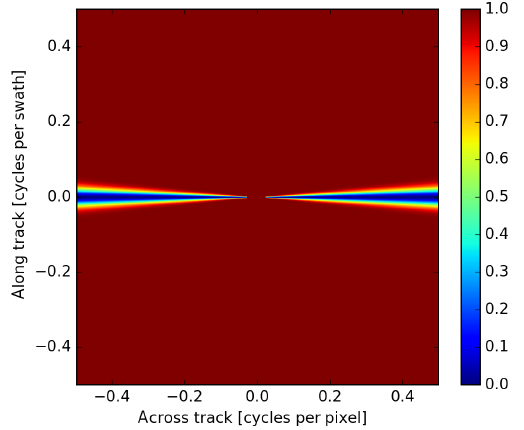
Figure 8. Spectral filter f (ν x ,ν y ) defined in Eq. (6) to remove CO